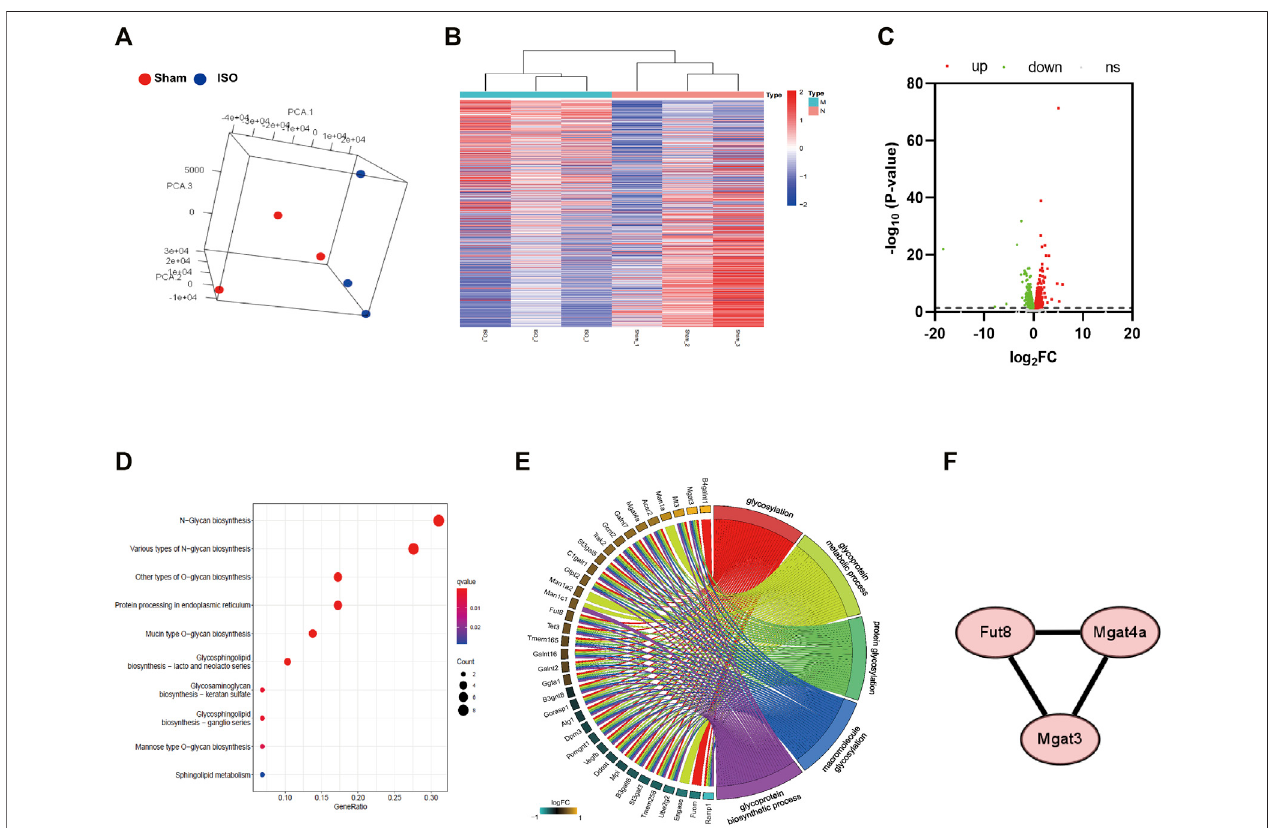
FIGURE 3 | Transcriptome analysis of heart tissue in mice with ISO-induced heart failure. (A) Principal Componet Analysis to visualize similarities and differences among samples. (B,C) Heatmap and Volcano plot indicates upregulated and downregulated genes with differential mRNA abundance in the ISO group relative to the Sham group measured using RNA sequencing. (D) KEGG pathway analysis was performed by mapping N-type glycosylated genes in GO enrichment. (E) Gene regulation network was plotted based on the number of enriched genes in GO term. (F) Differential genes involved in transferase during N-glycosylation synthesis between Sham and ISO groups. n = 5 mice per experimental group. ISO, isoproterenol; Sta, stachydrine hydrochloride.